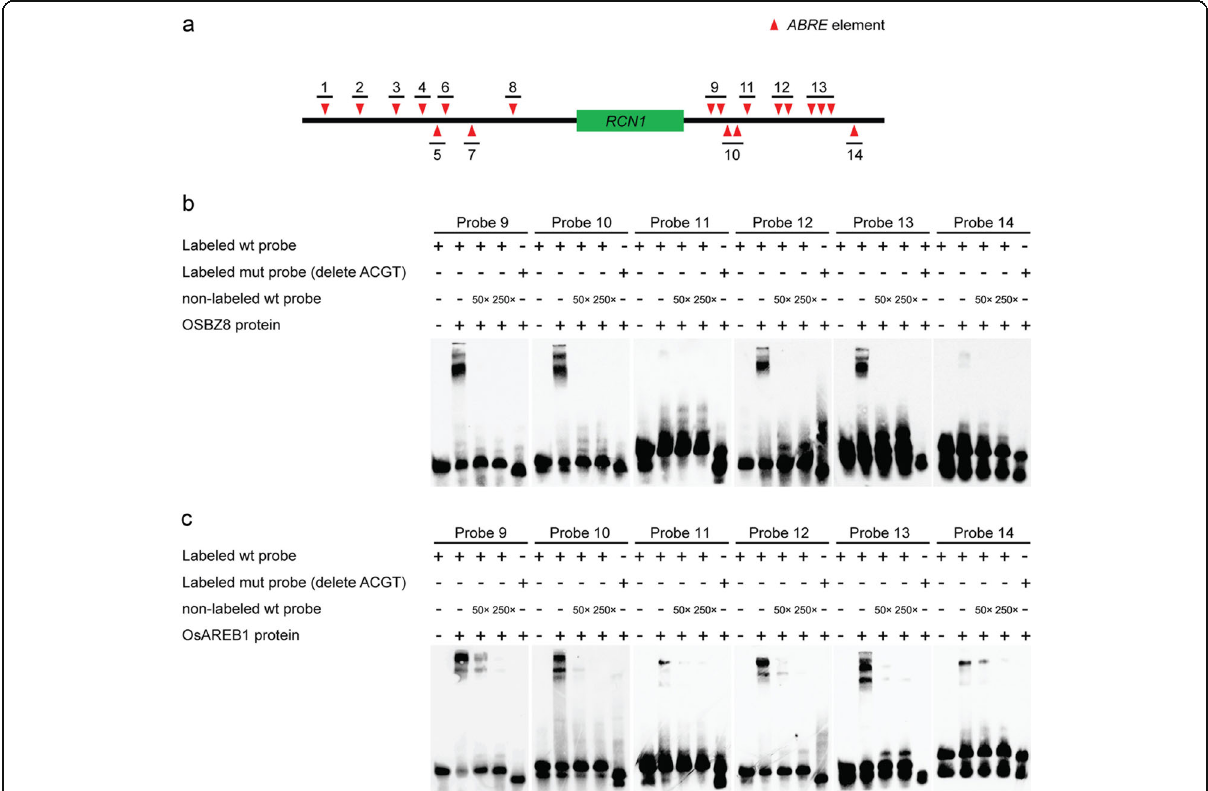
Fig. 3 Location of the probes in the genomic DNA of RCN1 ( a ). OSBZ8 ( b ) and OsAREB1 ( c ) were bound to the downstream sequence of RCN1 . Note: 50×: 50 times concentration; 200×: 200 times